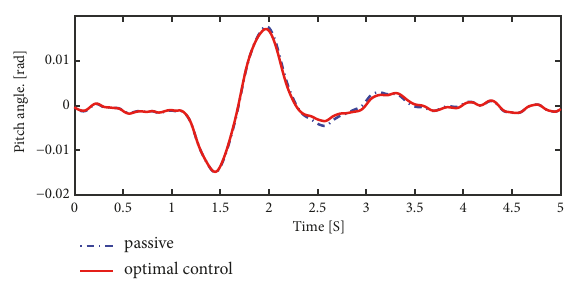
Figure 20: Time history response of suspension dynamic deflec- tions.